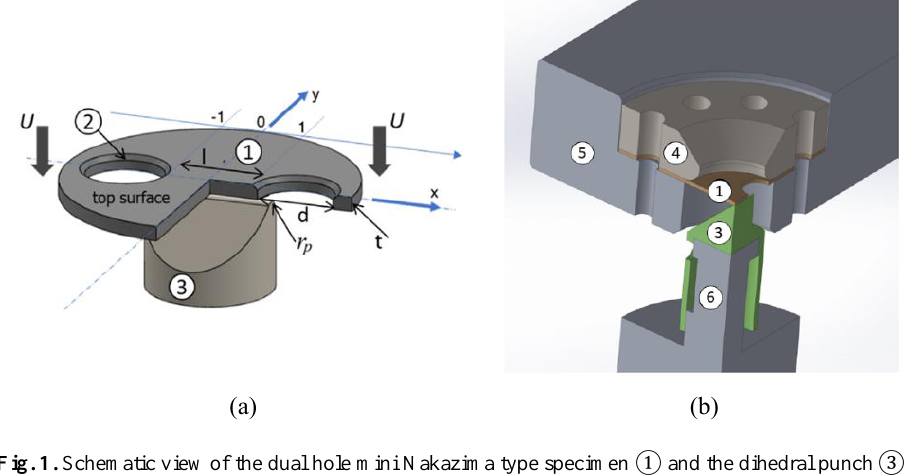
Fig. 1. Schematic view of the dual hole mini Nakazima type specimen ① and the dihedral punch ③ (a). Quarter view of the specimen inserted on the moving crosshead ⑤ of a drop weight tower with the dihedral punch ③ covering the sensing part of the load cell ⑥